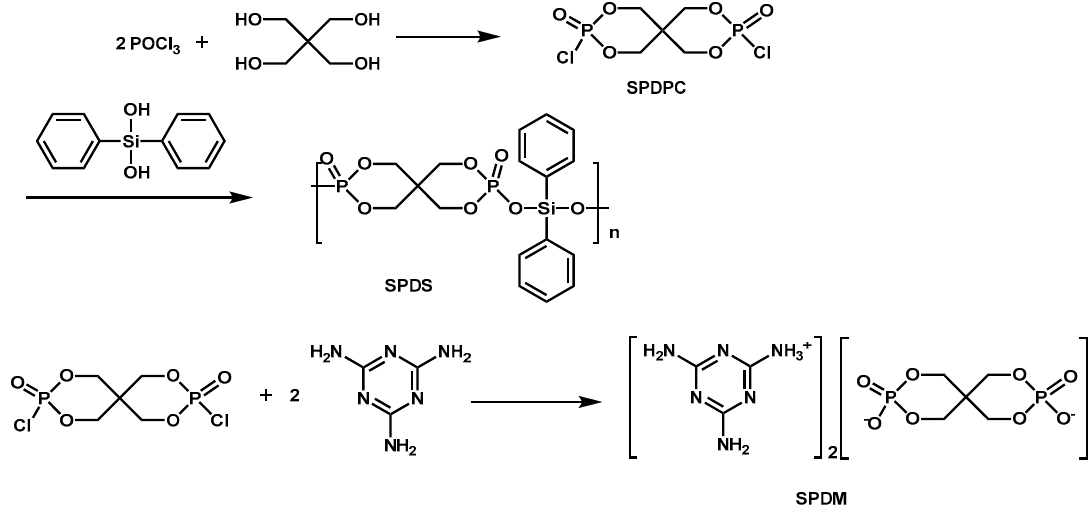
Figure 9. Synthetic routes to silicon/phosphorus-containing hybrid (SDPS) and mono (4, 6-diamino-1,3,5-triazin-2-aminium) mono (2,4,8,10-tetraoxa-3,9-di-phosphaspiro [5.5] undecane-3, 9-bis (olate) 3, 9-dioxide) (SPDM). Readapted with permission from Ref. [94], Copyright 2014, Elsevier Ltd.